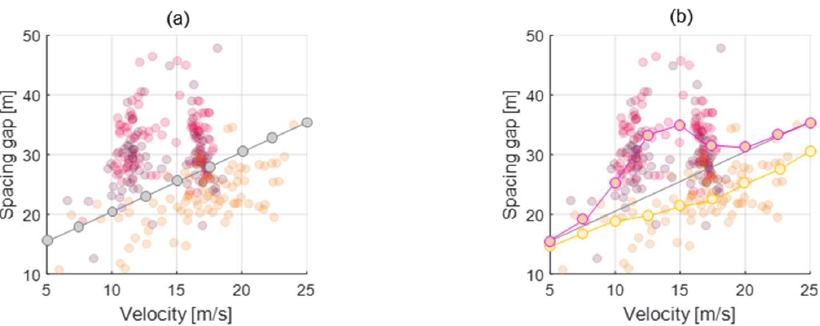
Figure 6. Parameter vector of spacing gap depending on the ego-vehicle velocity. ( a ) Initial parameter vector, ( b ) Updated parameter vector.